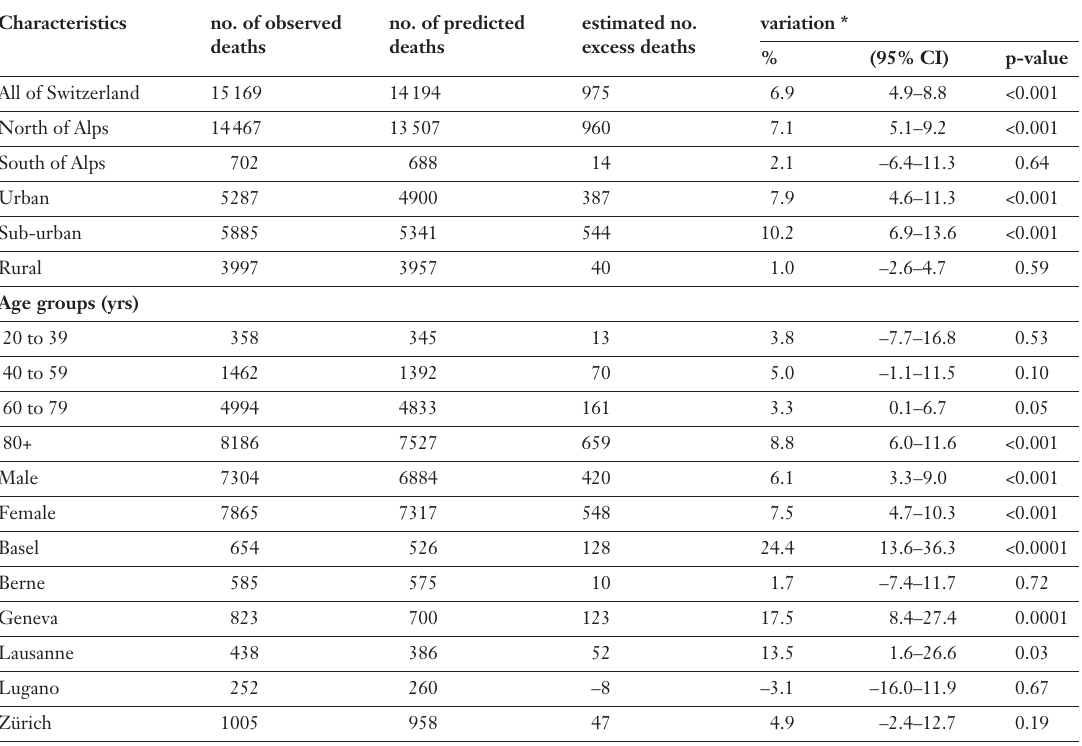
Ratio (observed/predicted)